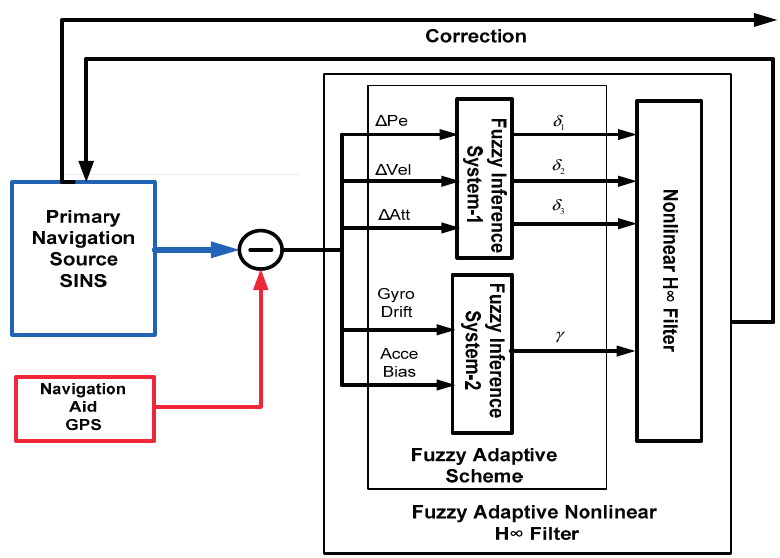
Figure 3. SINS/GPS integration based on a Fuzzy Adaptive Nonlinear H ∞